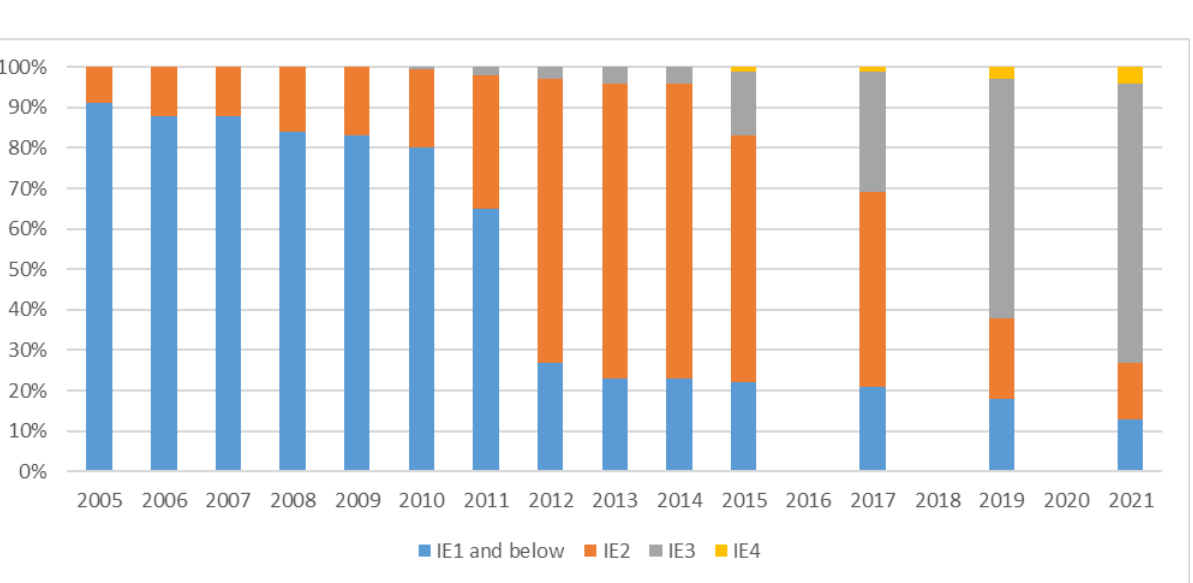
0%10%20%30%40%50%60%70%80%90%100% Figure 11. Estimation of EU-27 motor stock by efficiency class (Source: Authors).